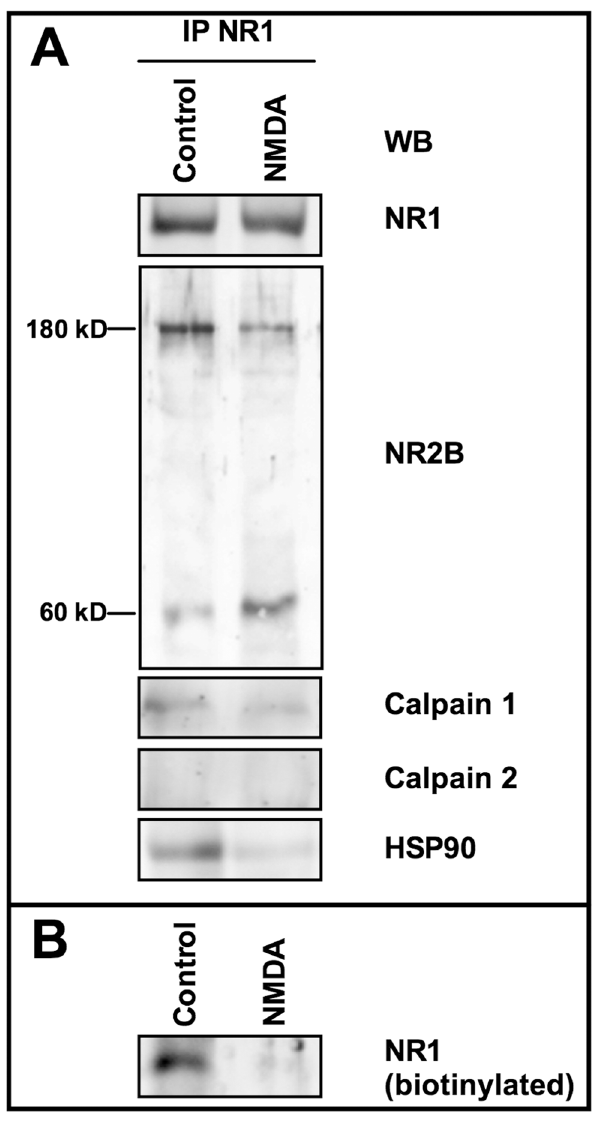
Fig 6. NMDAR cluster modifications in rat hippocampal synaptosomes following calpain activation. (A) Rat hippocampal synaptosomes were incubated at 37°C for 12 min with (NMDA) or without (Control) 100 μ M NMDA in HEPES buffer containing 1 μ M glycine and 1 mM CaCl 2 . Synaptosomes were lysed and immunoprecipitation was carried out with 1 μ g of anti-NR1 antibody. The immunoprecipitated material (IP NR1) was analyzed by immunoblotting (WB) to detect the indicated proteins. (B) Surface localization of NR1 subunit was also evaluated by biotinylation assay in rat hippocampal synaptosomes treated as in (A). NR1 was detected on a fraction (30 μ L) of eluted proteins (biotinylated) by immunoblotting. Each immunoblot is representative of four different